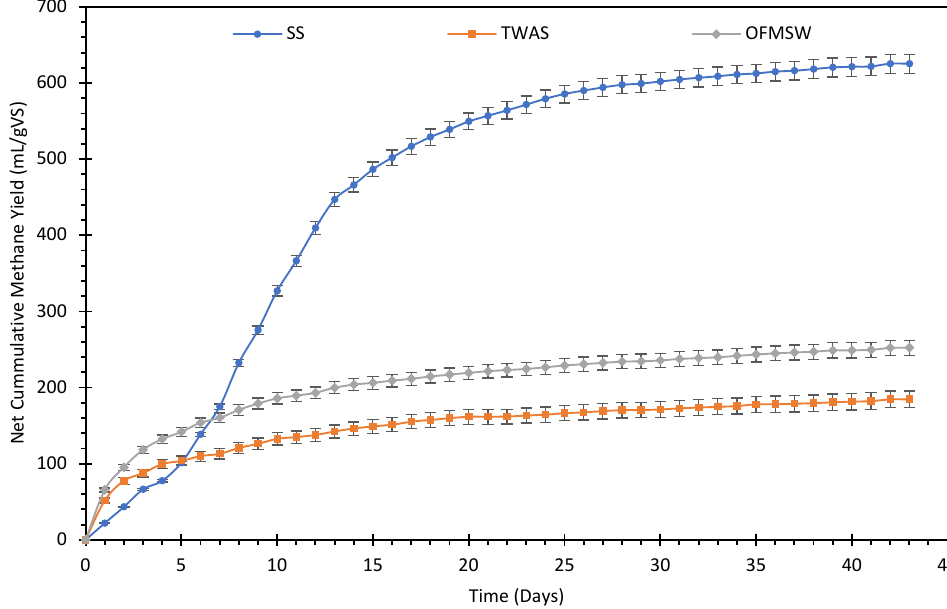
Figure 1. Average net cumulative methane yield (CMY) from the various single substrates used in this study .